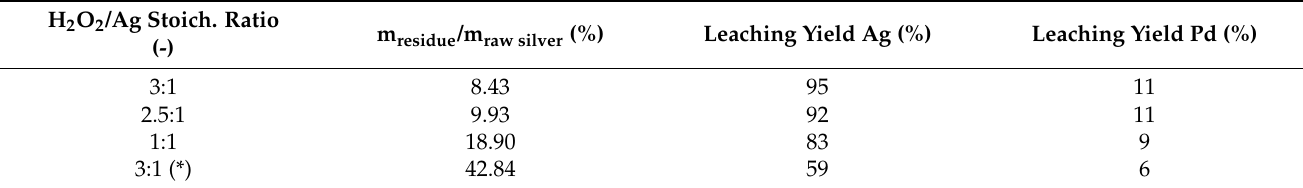
Table 2. Leaching results for different values of the stoichiometry. H 2 O 2 /Ag-ratio (Leaching time = 5 h, solid conc. = 300 g/L).